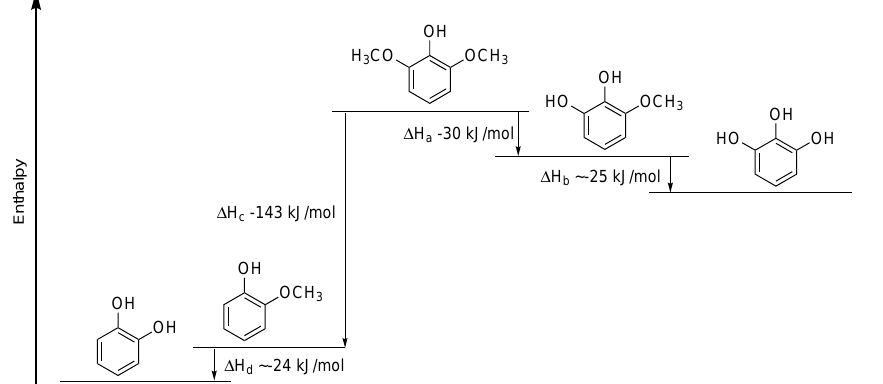
Fig. 9. Estimates of enthalpy differences between several products indicating methoxy